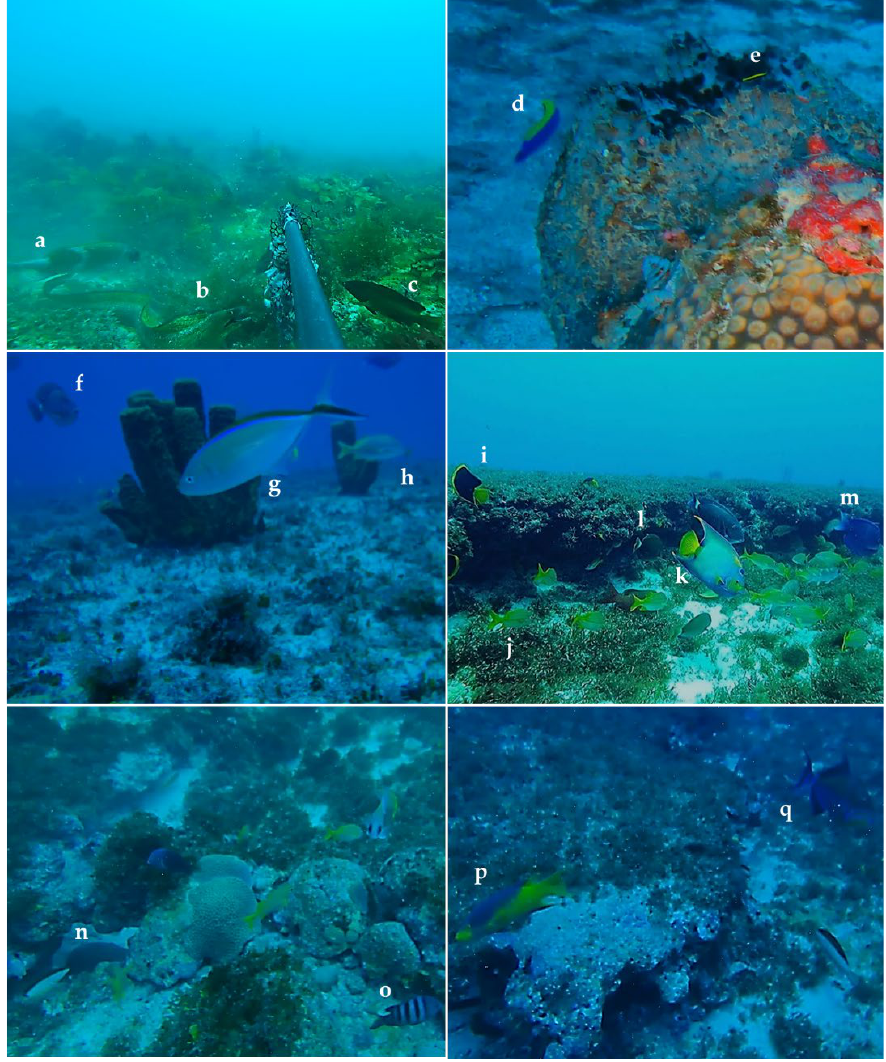
Figure 8. Fishes record in the mesophotic zone of Marine Protected Area Costa dos Corais using ROVs, BRUV cameras, and SCUBA between 30 and 68 m deep: ( a ) Holocentrus adscensionis , ( b ) Gymnothorax vicinus , ( c ) Cephalopholis fulva , ( d ) Halichoeres dimidiatus , ( e ) Elacatinus fígaro , ( f ) Acanthurus chirurgus , ( g ) Caranx ruber , ( h ) Haemulon plumierii , ( i ) Holacanthus tricolor , ( j ) schools of Haemulon squamipinna , ( k ) Holacanthus ciliaris , ( l ) Acanthurus bahianus , ( m ) Acanthurus coeruleus , ( n ) Ginglymostoma cirratum , ( o ) Abudefduf saxatilis , ( p ) Bodianus rufus , and ( q ) Balistes vetula . Among the recorded species, Holocentrus adscensionis (Holocentridae) was the only species that occurred in all areas. The largest numbers of species were recorded at São Miguel dos Milagres (n = 34), followed by Porto de Pedras (33), Japaratinga (30), Maragogi (20), Parede (5), and Barra de Santo Antônio (3). Porto de Pedras and São Miguel dos Milagres also had the largest numbers of exclusive recorded species (9), followed by Japaratinga (8) and Maragogi (2), while Barra de Santo Antônio did not have any exclusive records (Table 4; Figure 8).